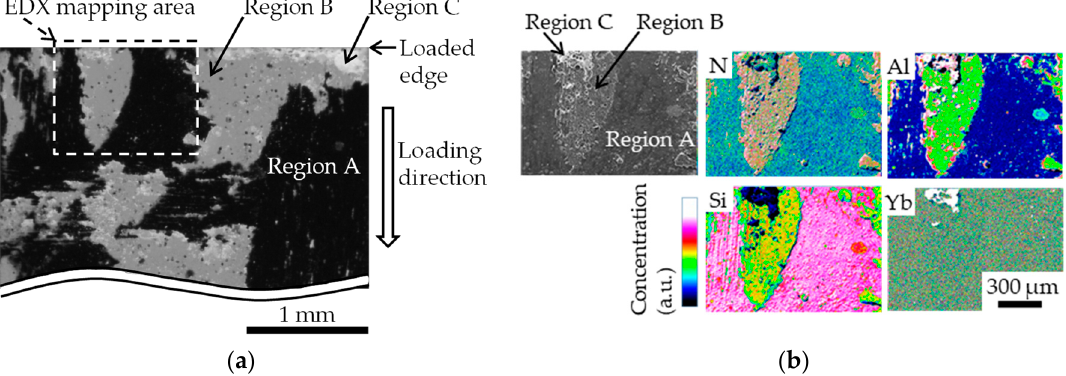
Figure 11. ( a ) Top view of fracture surface of specimen after interface fracture test and ( b ) EDX maps of selected area in fracture surface indicated by a dashed rectangle in ( a ).